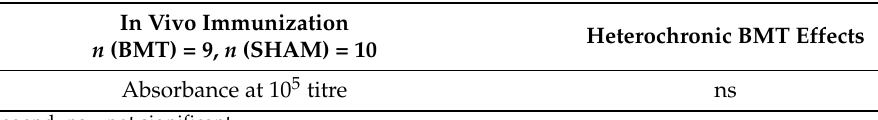
Table 8. In vivo functional testing. In Vivo